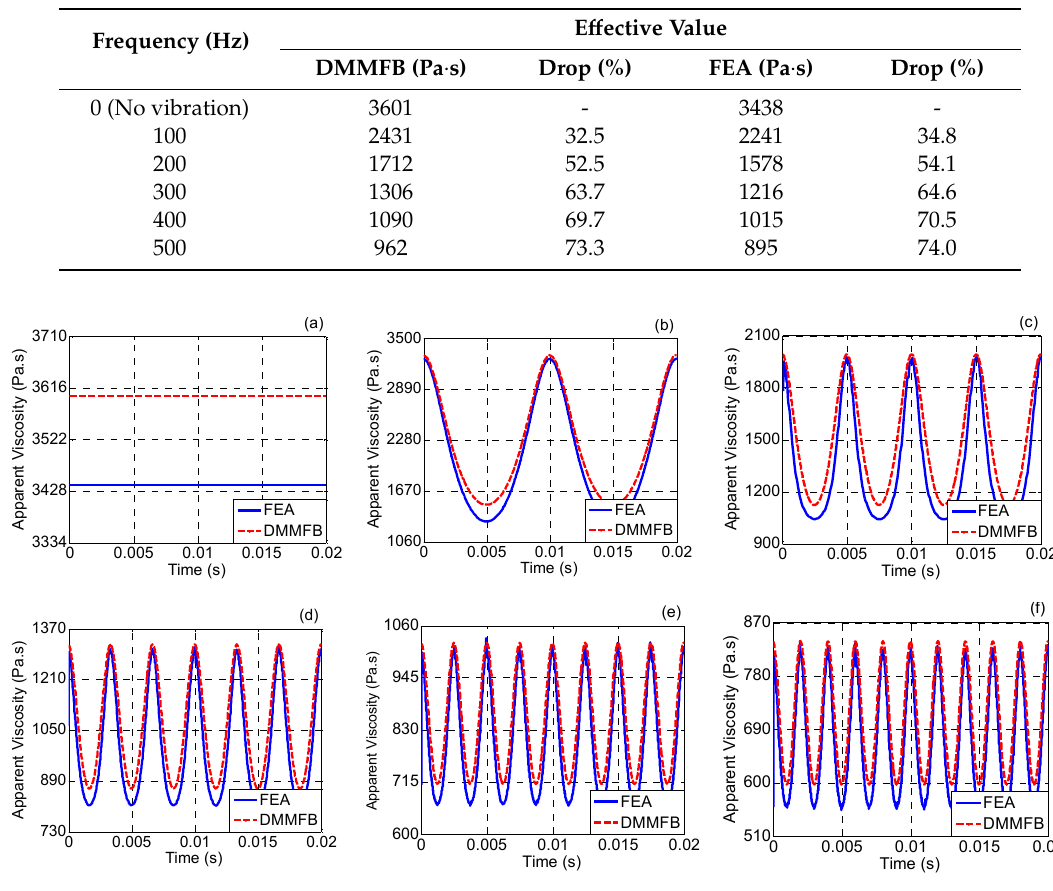
Figure 14. The apparent viscosity without and with 0.35 g vibration applied at different frequencies.